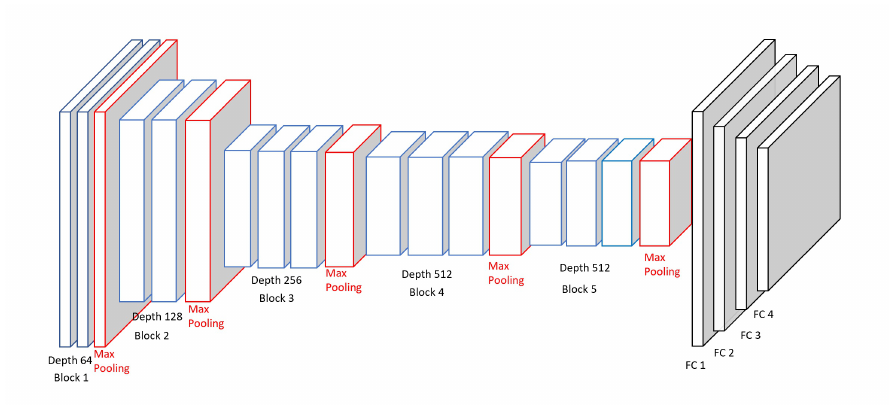
Figure 3. The architecture of the proposed network model. This network adapts a pre-trained VGG-16 network as a feature extractor.